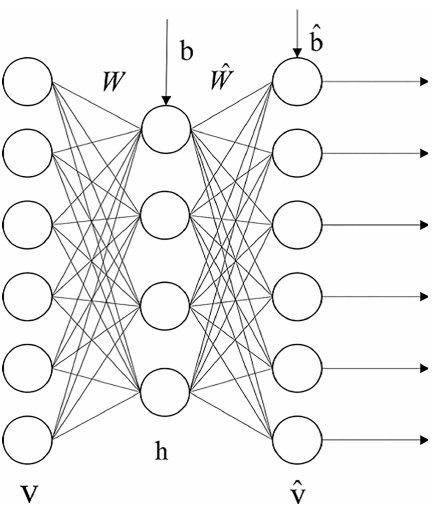
Figure 1. An auto-encoder with one hidden layer (Liu et al., 2015).